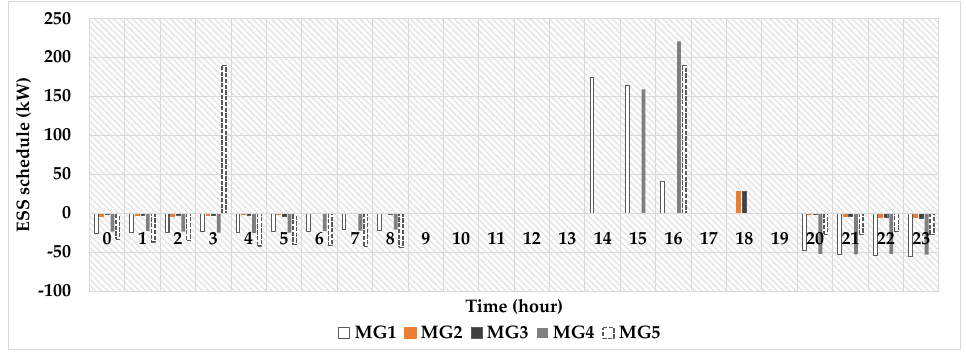
Figure 6. Optimal energy storage system (ESS) scheduling of each MG under a single operation.